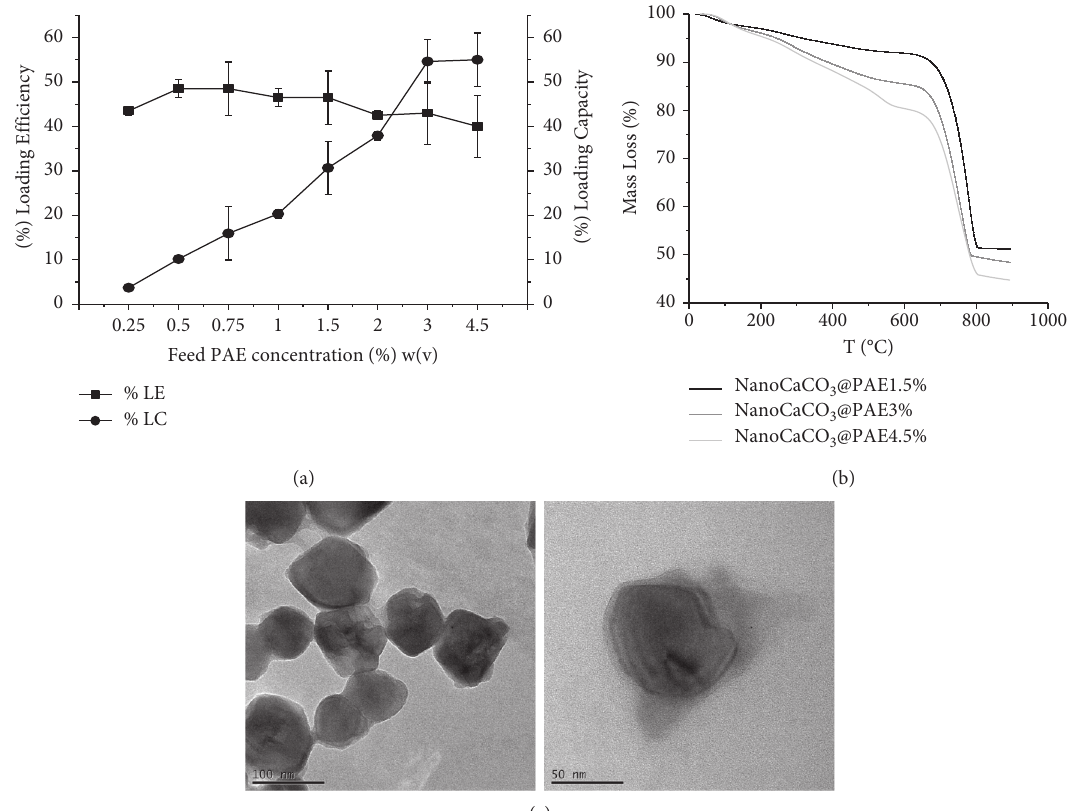
Figure 1: (a) Loading efficiency and loading capacity plot over PAE loading concentration by spectrophotometry analysis. (b) TGA traces of nanoCaCO 3 @PAE samples obtained from three different loading concentrations (1.5%, 3%, and 4.5% w/v). (c) TEM images at different magnifications of nanoCaCO 3 @PAE (deriving from PAE 3%